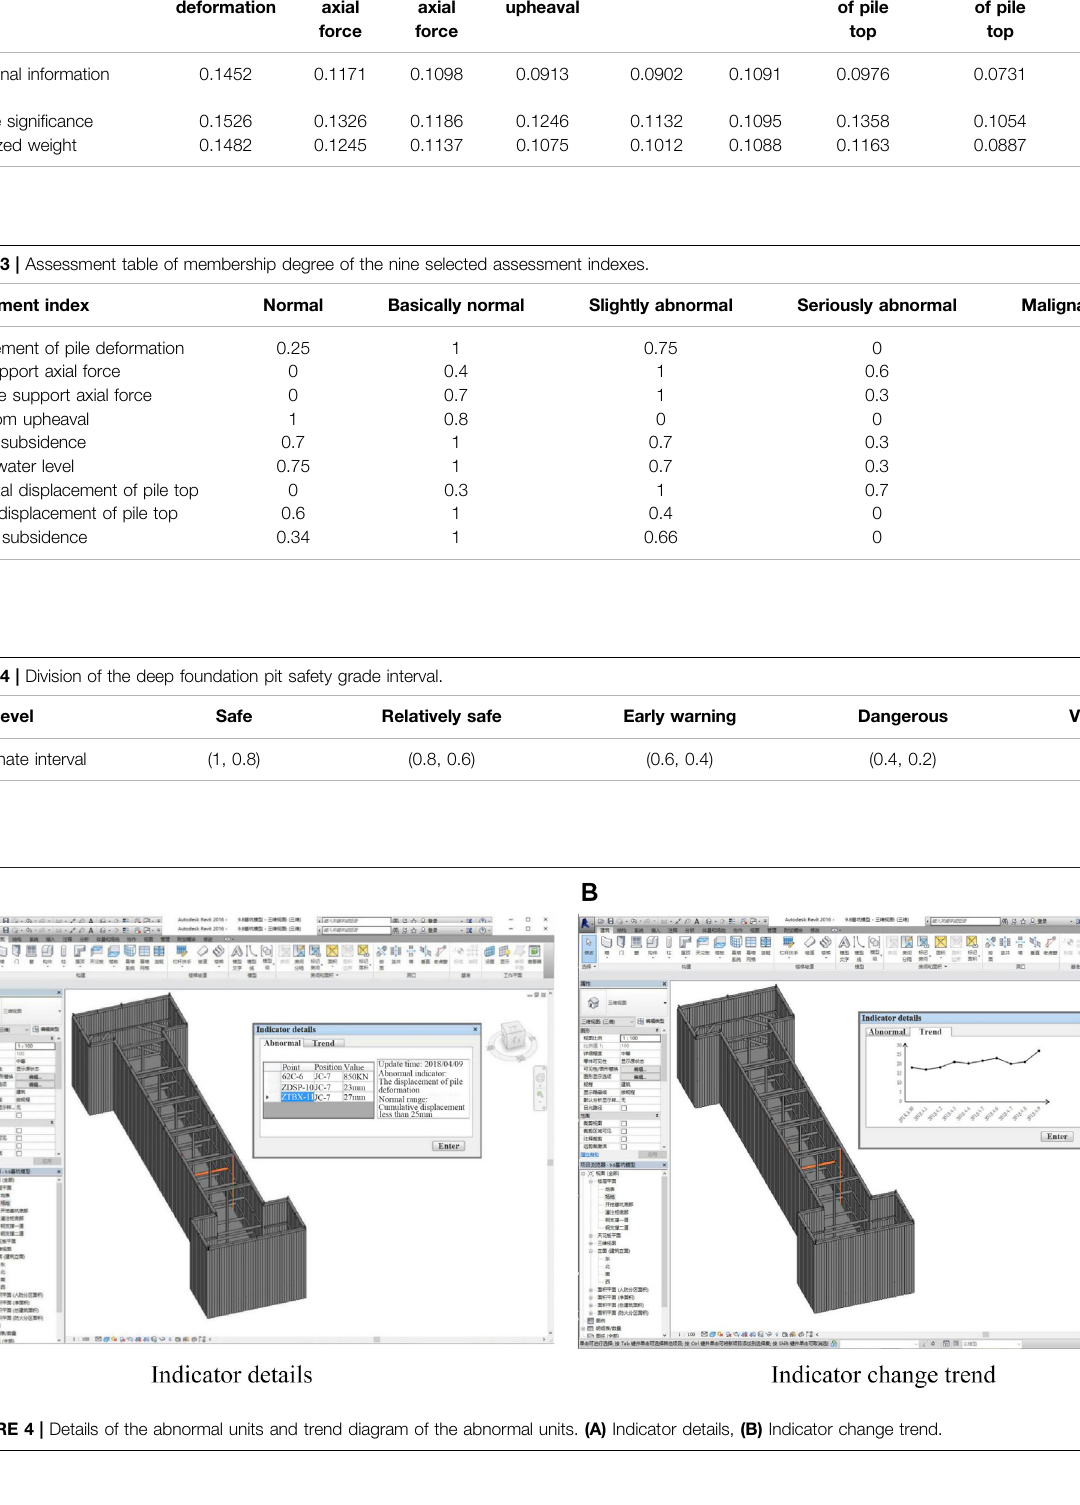
Frontiers in Earth Science |